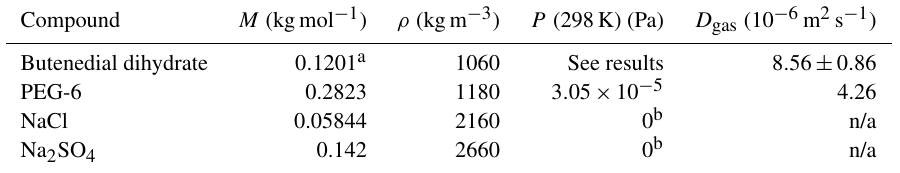
Table 2. Physical parameters for each compound used in the model. A gas phase diffusivity is not applicable (n/a) to the inorganic